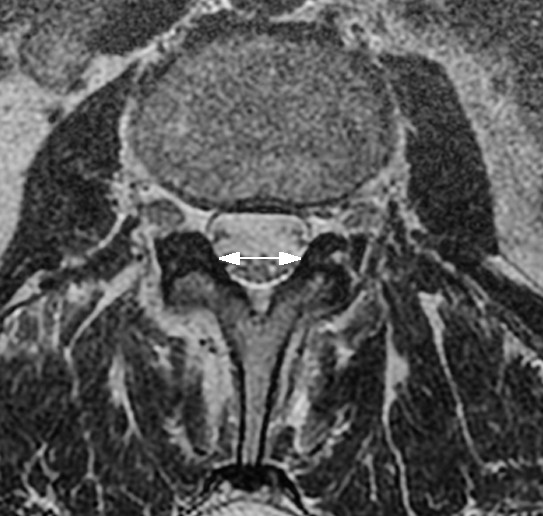
T2 weighted transaxial fast spin echo MR image of the lumbar spine at the level of L3. The white arrow indicates the ligamentous interfacet distance measured between the inner surfaces of flaval ligaments on a line connecting the joint space of facet joints.